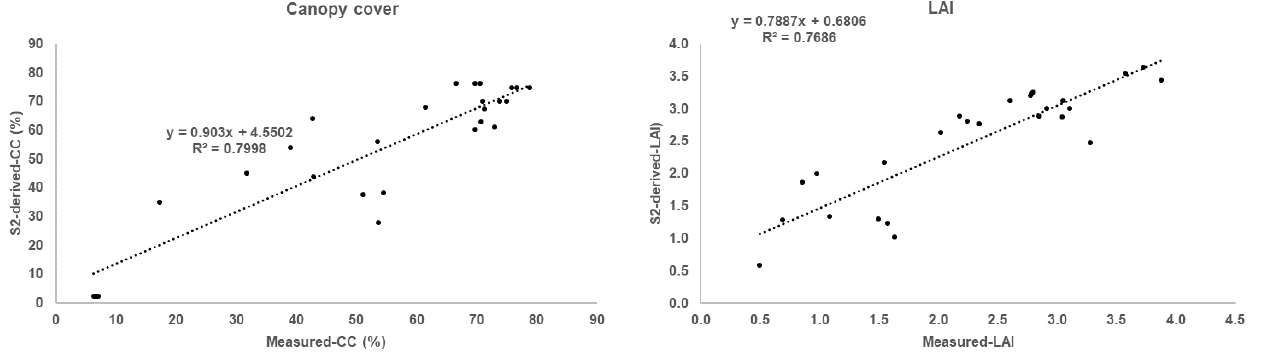
Table 3. Crop parameters used for wheat simulations by AquaCrop. Parameter Description